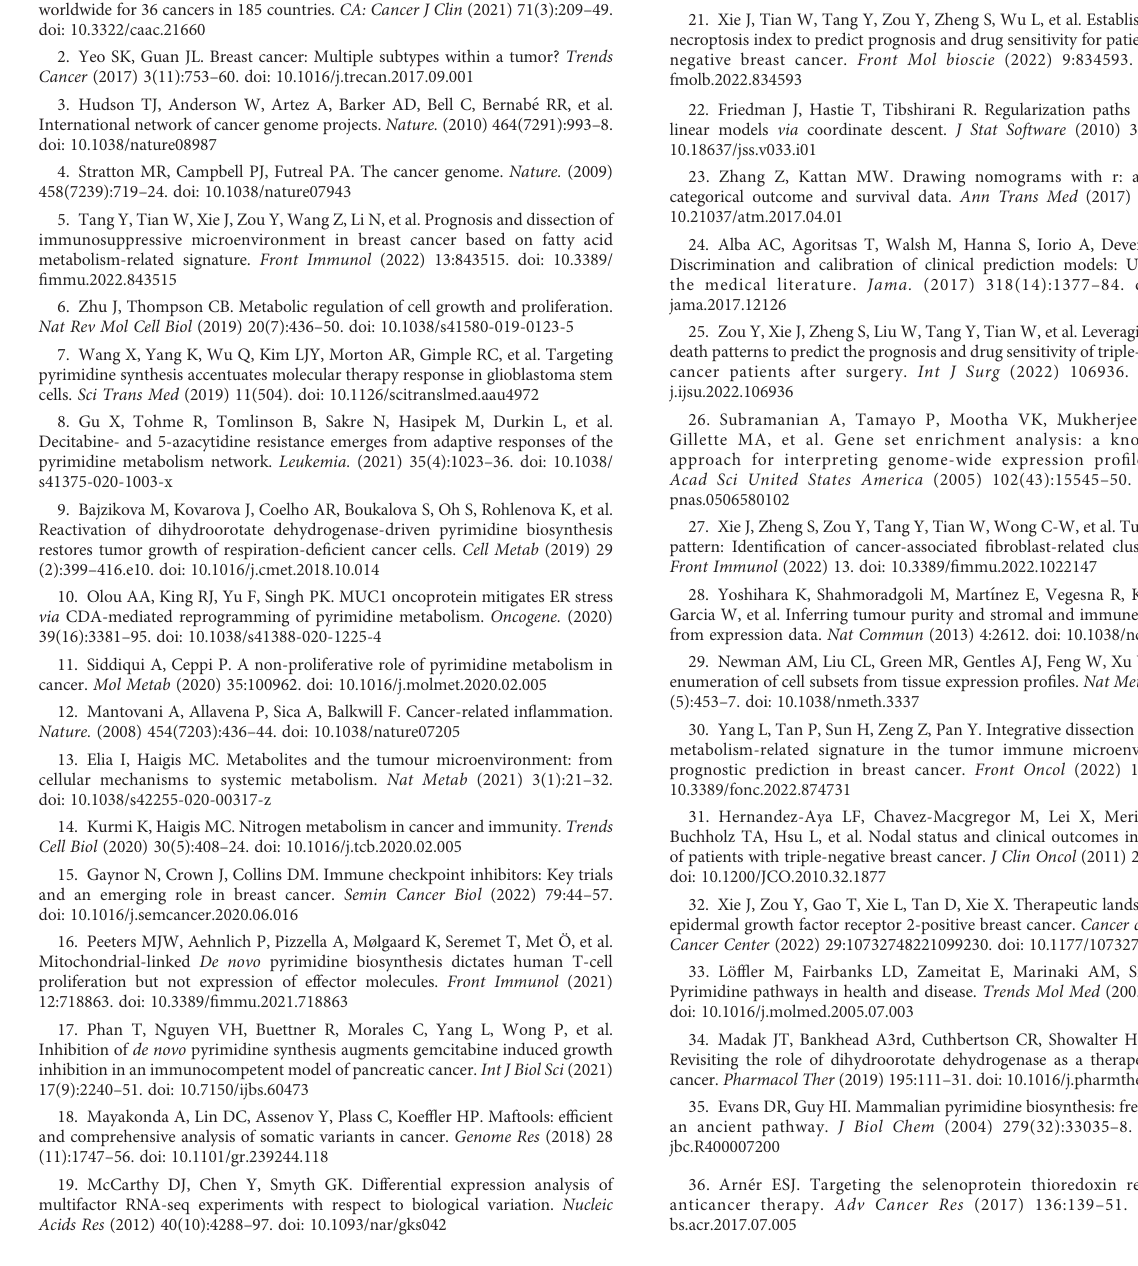
SUPPLEMENTARY FIGURE 1 The acquisition of 163 credible PMGs. (A) Venn diagram to acquire 163 overlapping PMGs in TCGA-BRCA, METABRIC and GSE96058 datasets. (B) The detailed information on 163 eligible PMGs. SUPPLEMENTARY FIGURE 2 Heatmaps incorporating PMI and clinical parameters in relation to gene expression levels in eight signature-included PMGs in METABRIC (A) and GSE96058 (B) .